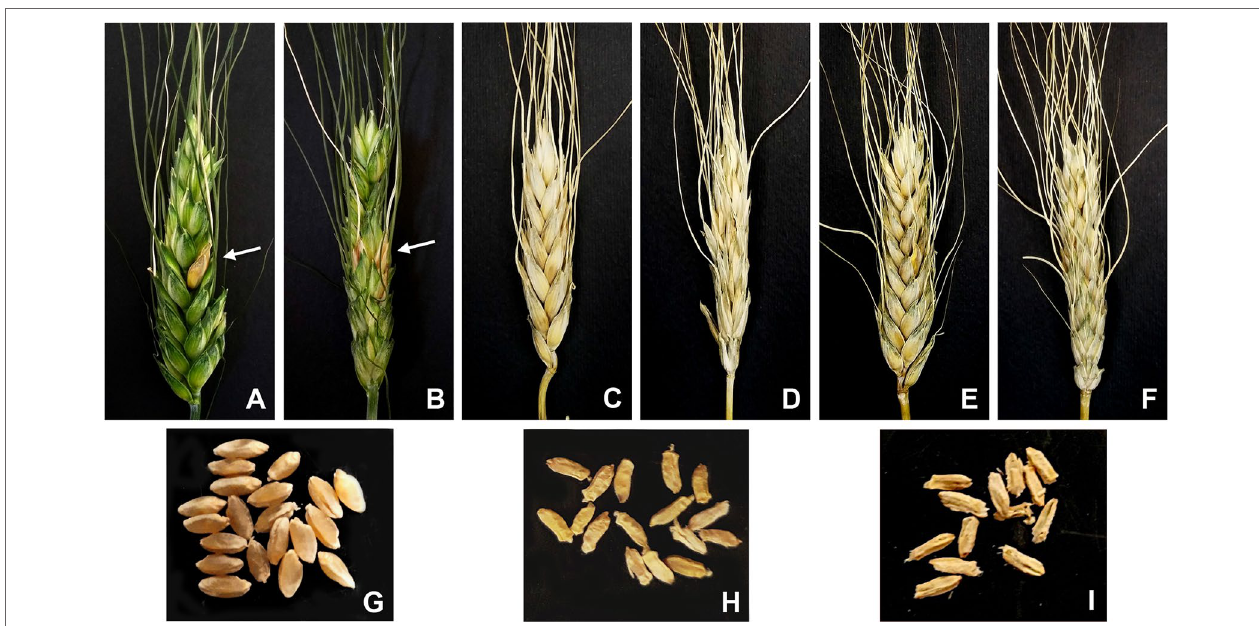
FIGURE 4 | Phenotypes of F. graminearum inoculated spikes (21 dpi) and of corresponding harvested seeds of durum wheat- Thinopyrum spp. 7A-7el 1 L-7EL recombinant lines and control lines. (A-B) FHB resistant ( Fhb-7EL +) recombinant (HOM+), with arrows pointing at the diseased floret(s)/spikelet(s); fully diseased spikes of HOM− segregates in the same BC 2 F 2 progenies from the cross to durum wheat of 5x F 1 s (C-D) and of durum wheat cv. Simeto (E-F) . Mature seeds of HOM+ (G) , HOM− (H) , and Simeto (I) genotypes show a sharp difference in plumpness.